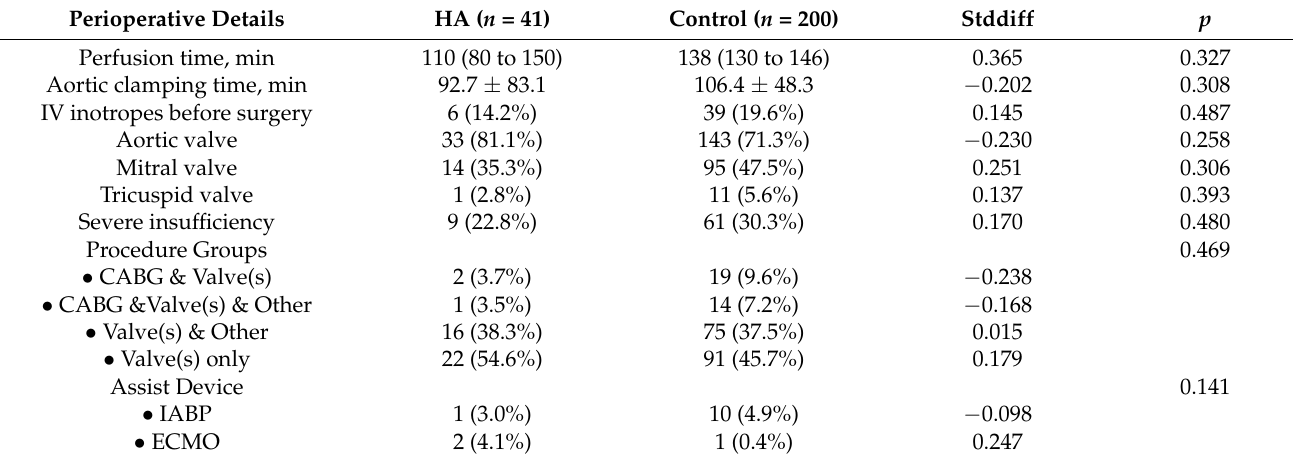
Table 2. Perioperative details after inverse probability of treatment weighting